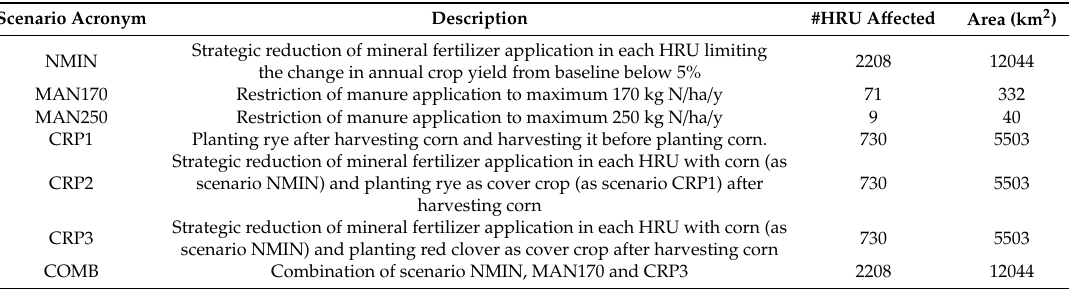
Table 5. Scenario descriptions (# is the number of